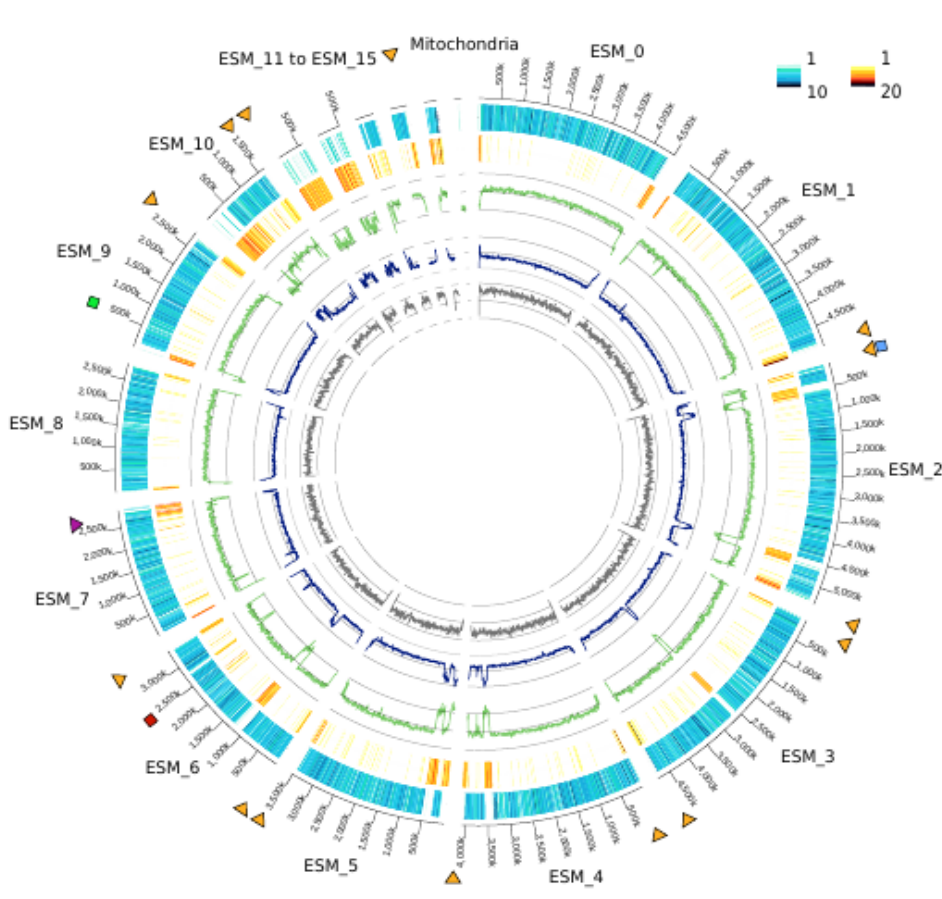
Figure 1 . Circular representation of the final genome assembly of the Cryphonectria parasitica isolate ESM015. First circle: ID scaffolds, telomeric motifs (orange triangle), mating type locus (dark purple triangle), genes mapped in Eseubio-Cope et al. (2009) are nam-1 (blue square), rDNA ITS (red square) and β -tubulin (green square). Second circle: Number of predicted genes using BRAKER (Hoff et al. 2019) per 10kb. Color scale is shown in the top-right. Third circle: Number of transposables elements per 10kb. Color scale is shown in the top-right. Fourth circle: GC rate per 10kb, black lines represent 60%, 50%, and 40%. Fifth circle: Illumina reads mapping coverage. Sixth circle: Nanopore reads mapping coverage. Black lines represent 0, 30 and 60X. Coverage of the mitochondria and the 20kb ITS rDNA region on the ESM_6 scaffold has been excluded for